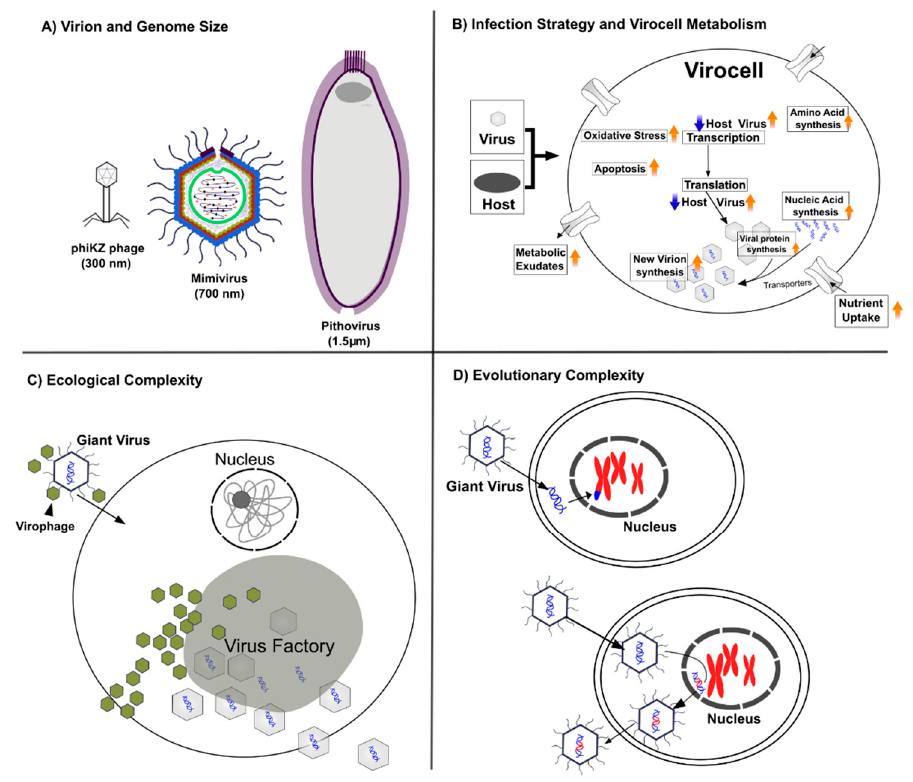
Figure 1. Major themes of viral complexity discussed here, together with illustrative examples. ( A ) Virion and genome size; some of the largest viruses discovered to date are given. ( B ) Virocell metabolism; example of virus-mediated physiological changes during infection (adapted from [3]). ( C ) Ecological complexity; giant virus–virophage interactions are shown. ( D ) Evolutionary complexity; gene exchange between viruses and hosts (adapted from [4]).